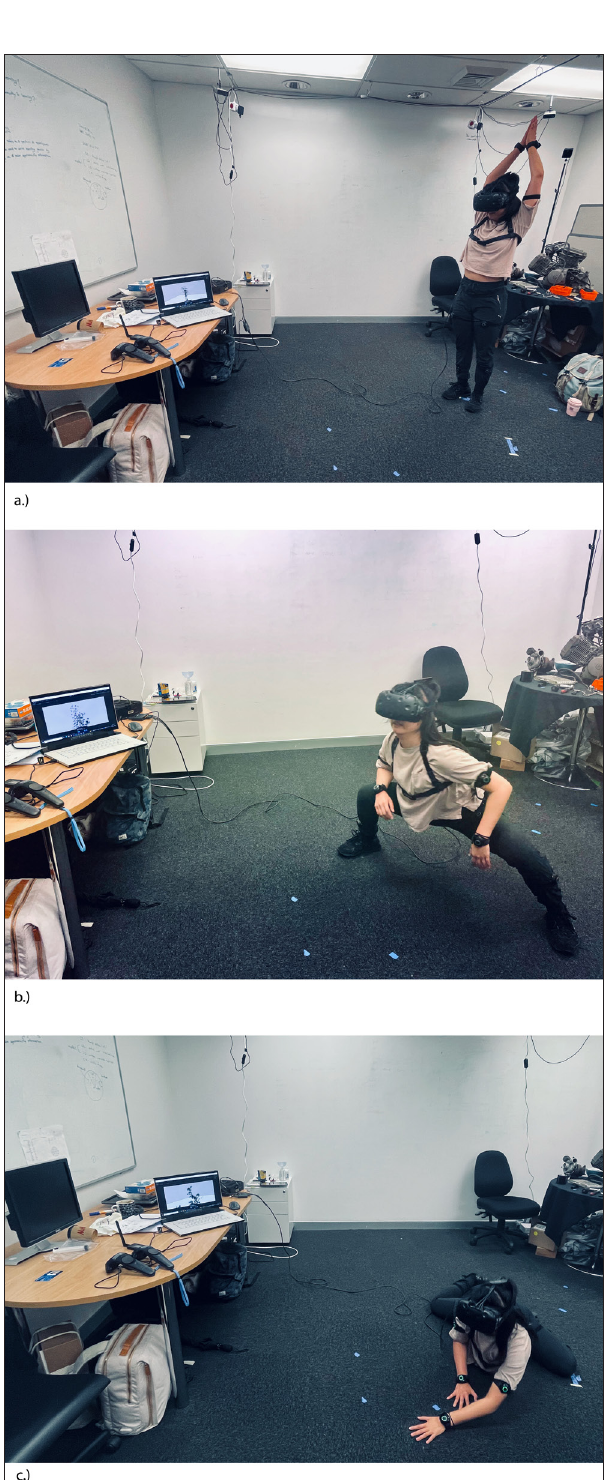
Figure 5 (a,b,c): Dancing as normal in Virtual